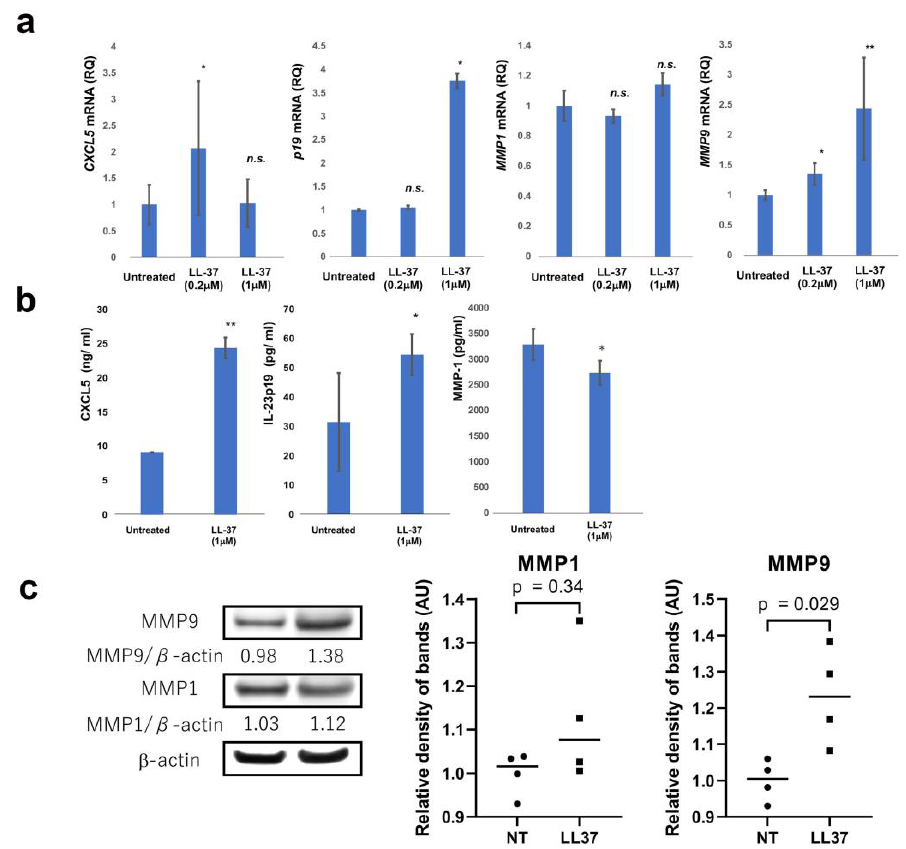
Figure 3. Expression of IL23A , CXCL5 , MMP1 , and MMP9 mRNA in A375 melanoma cells stimulated with or without LL-37 were analyzed by quantitative RT-PCR using the ΔΔ Ct method (n = 3). The data from each donor were obtained by triplicate assays, and then the mean ± SD was calculated. ( a ) Culture supernatant from A375 was harvested as described in Materials and Methods and meas- ured by ELISA (n = 3) ( b ). MMP-1 and MMP-9 production was analyzed by Western blotting ( c ). Data from each donor were obtained from triplicate assays, and mean ± SD values were calculated. Representative data from at least three independent experiments are shown. * marks a significant ( p < 0.05) difference. ** marks a significant ( p < 0.01) difference. The uncropped blots are shown in Figure S1. n.s.: not significant.